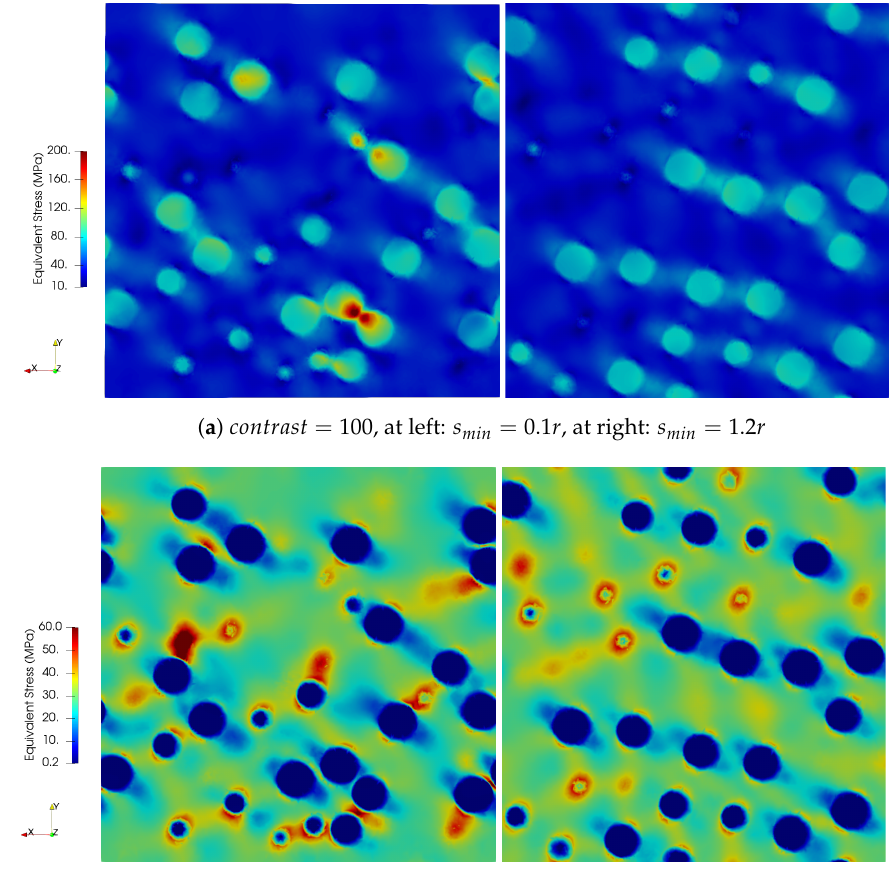
Figure 10. Local equivalent stress at SR = 10, f v = 13.4 % for extreme s min values and contrasts of 100 and 0.01—the cross-sectional views of